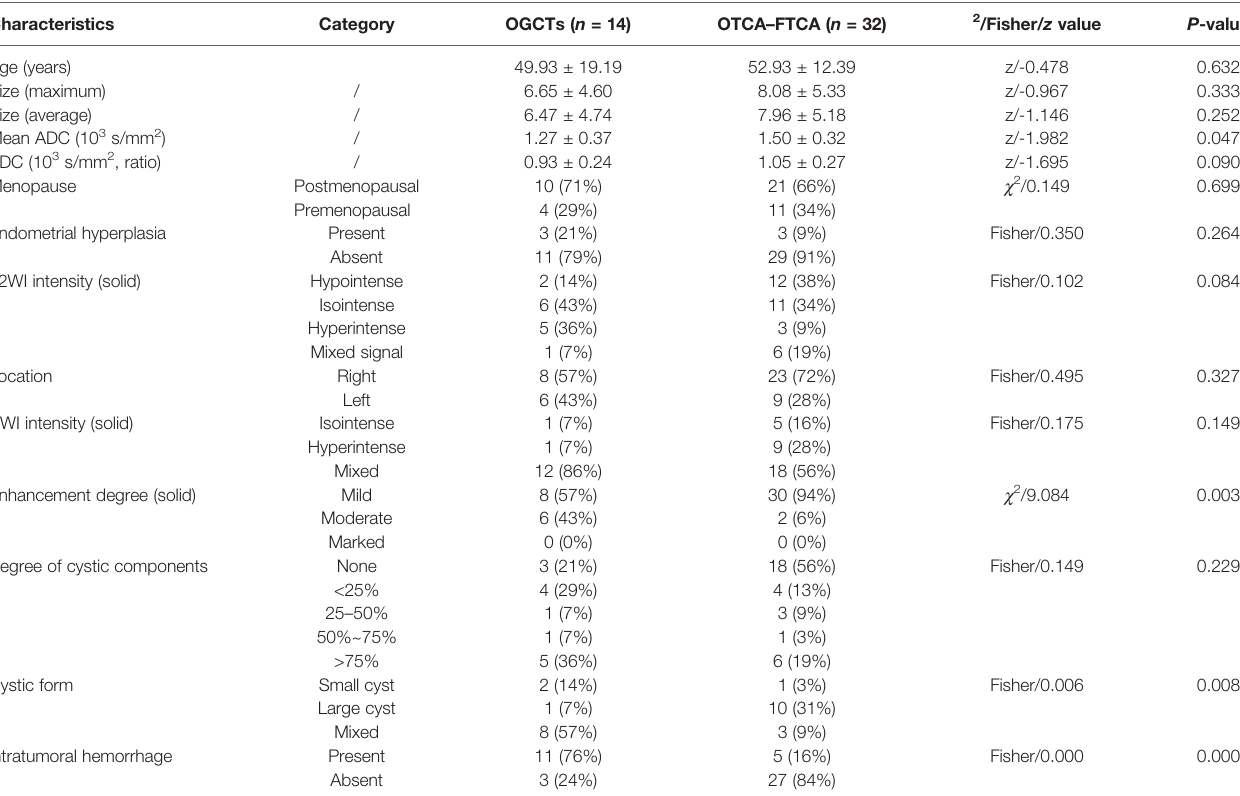
TABLE 2 | Details of the clinical and MR imaging-based characteristics of 14 histologically proven OGCTs and OTCA – FTCA in 32 patients.